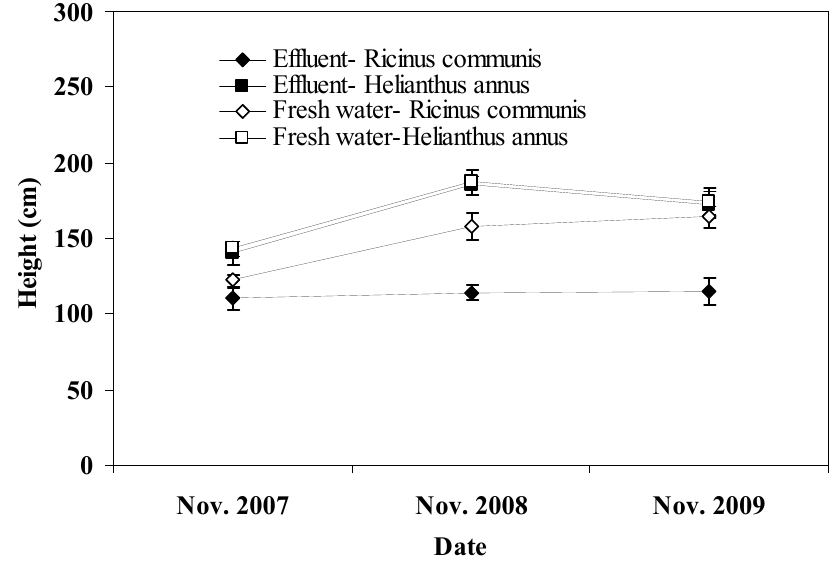
Figure 5. Plant height of different plant species at the end of the three irrigation periods.